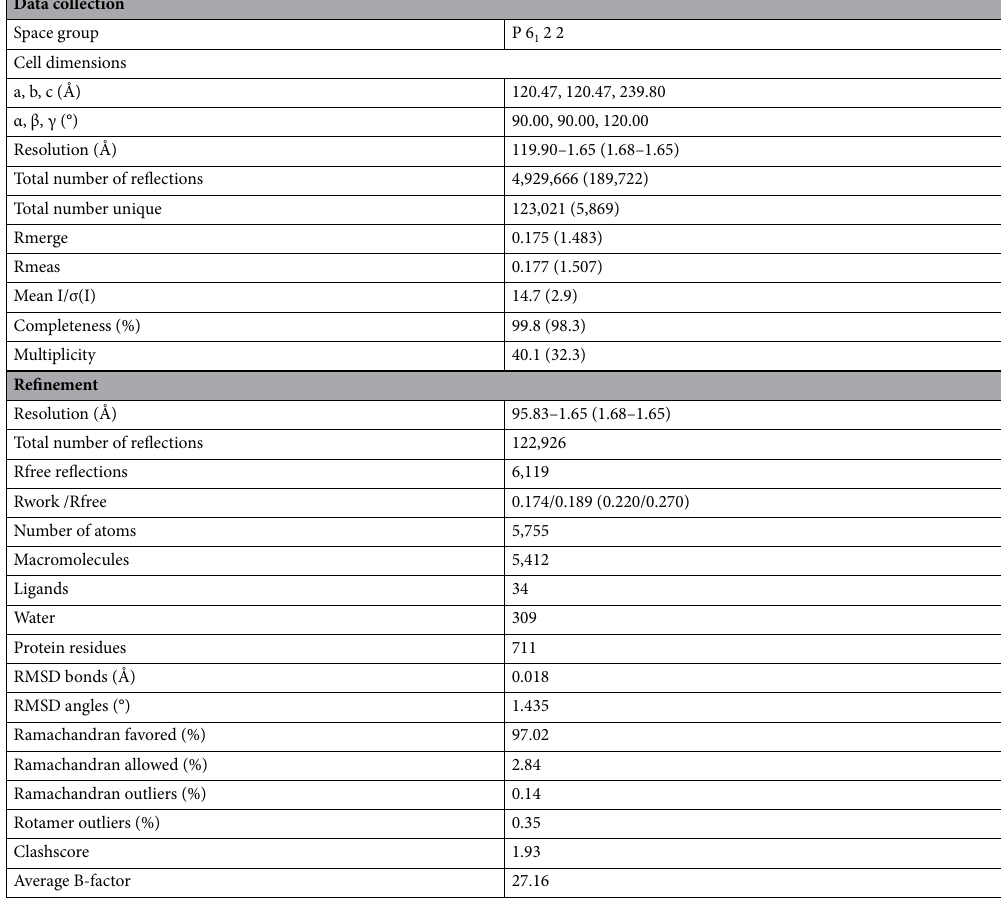
Table 4. X-ray data collection and refinement statistics. Statistics for the highest resolution shell are shown in